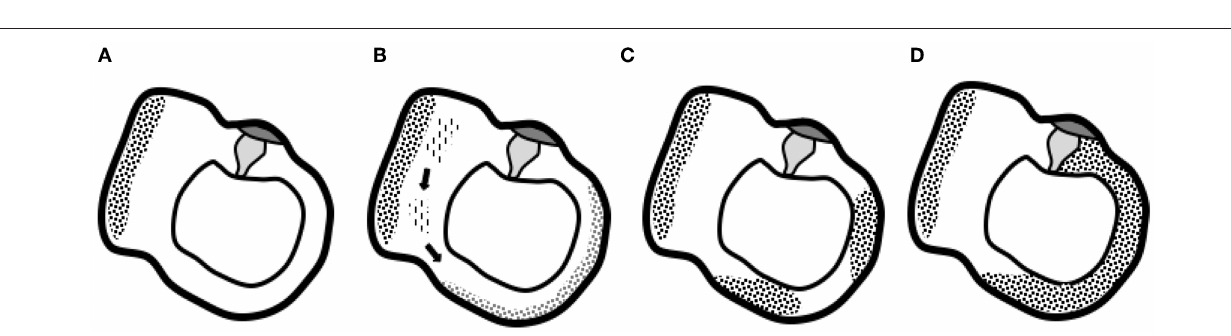
FIGURE 4 | Graphical representation of the suggested hypothesis. (A) Normal situation of the utricle and lateral semicircular canal with the utricle’s macula and semicircular canal’s cupula. (B) Progressive degeneration of the membranous labyrinth in the utricle might produce proteins that dislocate and accumulate in the semicircular canal. (C) Deposits eventually completely obstruct the semicircular canal and prevent the cupula from detecting angular acceleration of endolymph (D) , the end-stage ossification